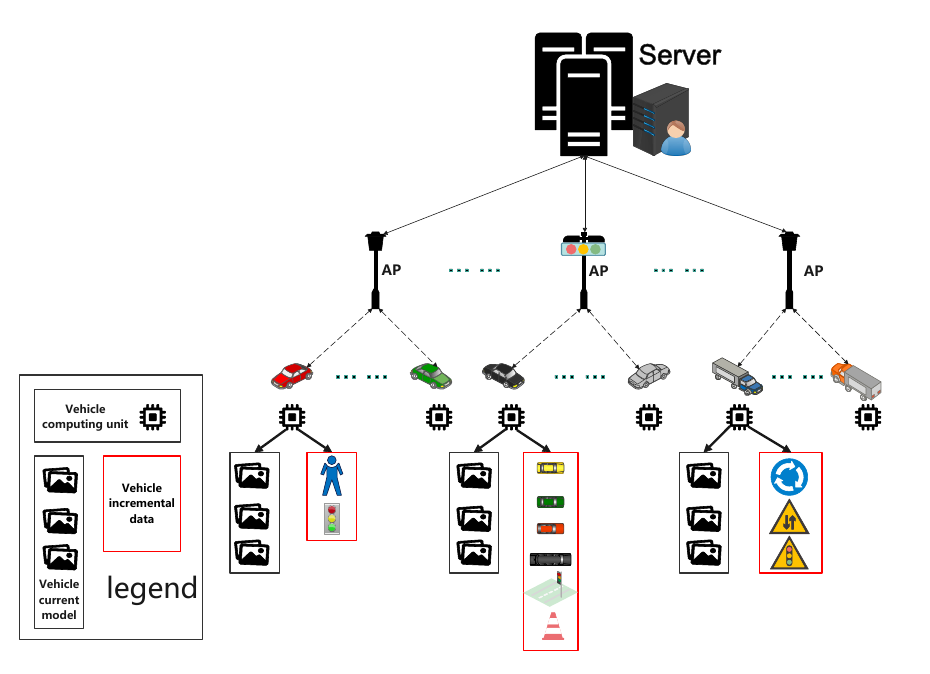
Figure 2. System